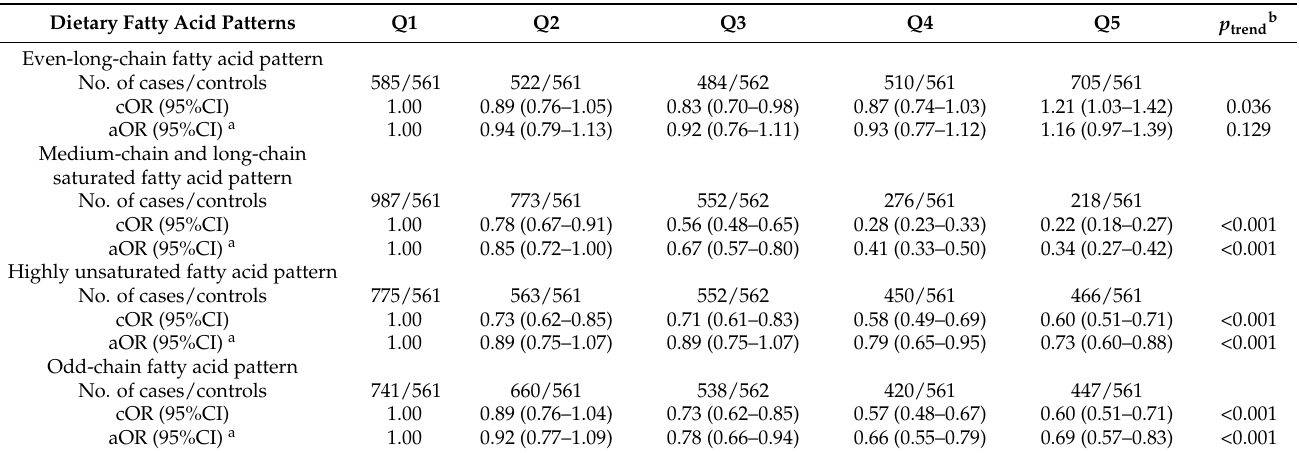
Table 3. Odds ratios and 95% confidence intervals of colorectal cancer across quintiles of dietary fatty acid